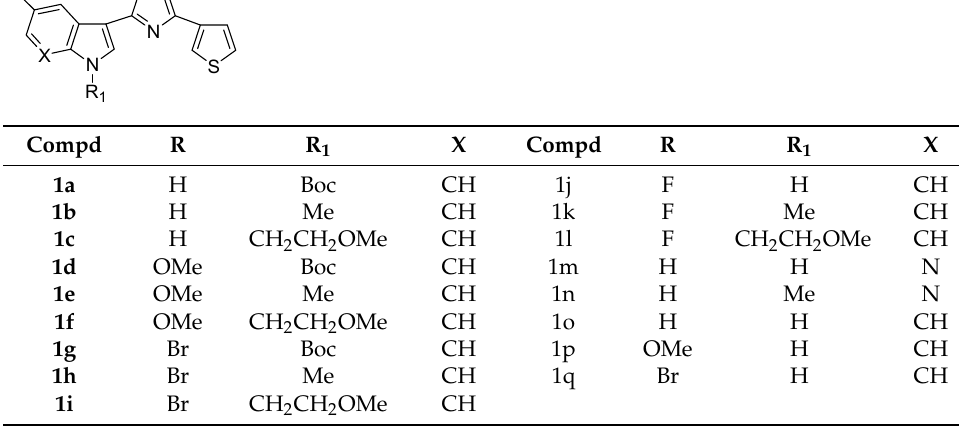
Table 1. Substituted 3-[4-(thiophen-3-yl)-1,3-thiazol-2-yl]-1 H -indoles 1a–q .